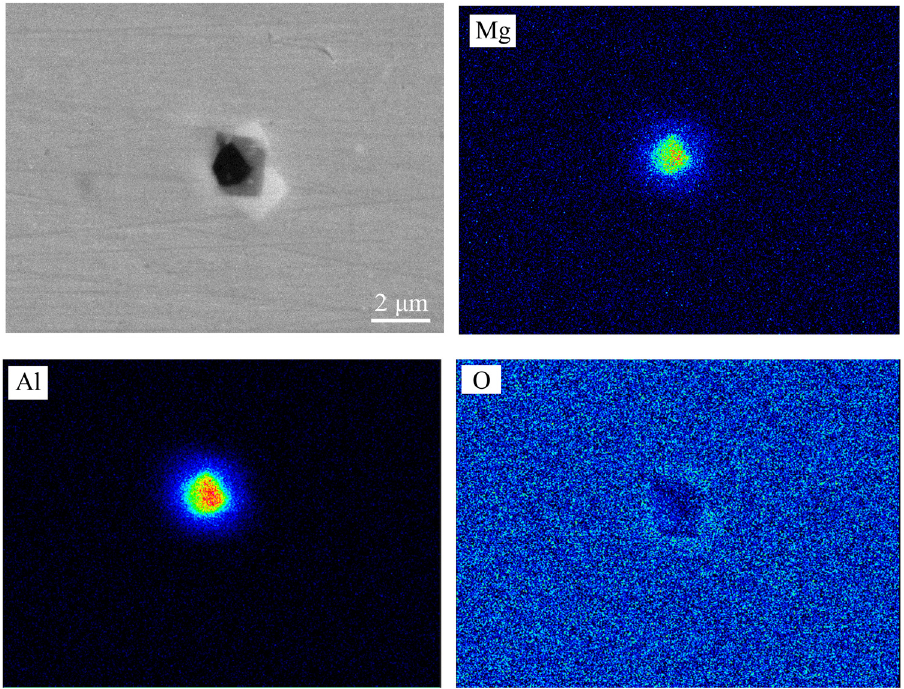
Figure 2: EPMA images of elemental distribution of inclusions in FSS1 steel.